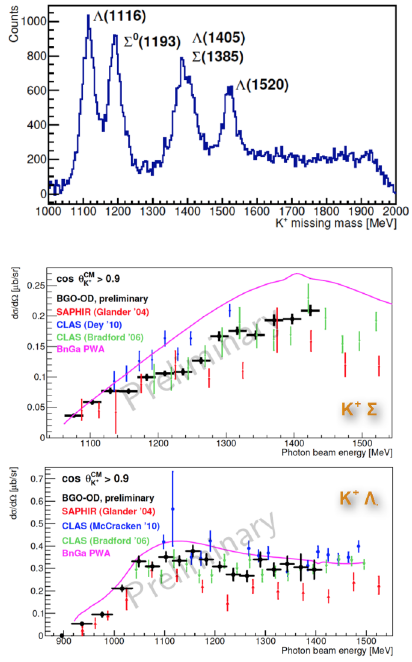
Figure 6. Missing mass to the K + identified in the forward spectrometer and the tagged photon.